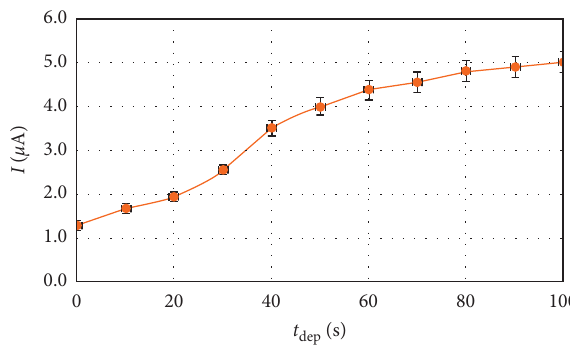
p for Figure 7: Effect of deposition time ( t dep ) on the anodic stripping peak current of 0.05mg l − 1 Hg 2+ in 0.05molL − 1 HCl, E dep � − 0.5V, and sweep rate 0.04V s − 1 .